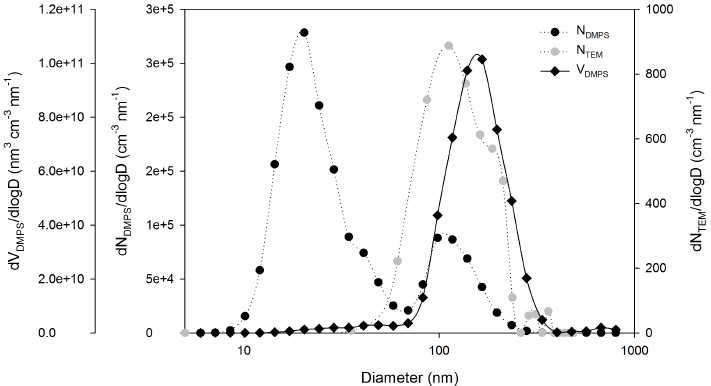
Figure 3. Number and volume size distribution of particles generated from aqueous tar (sample 16-d2) measured with TEM and DMPS. Table 1. Optical parameters of tar ball particles generated from the aqueous phase. The AAE is calculated between 467 and 652nm, the mass absorption coefficient (MAC) and the refractive indices are for 550nm. Sample Tube furnace AAE MAC Re Im Volume of name temperature (m 2 g − 1 ) large